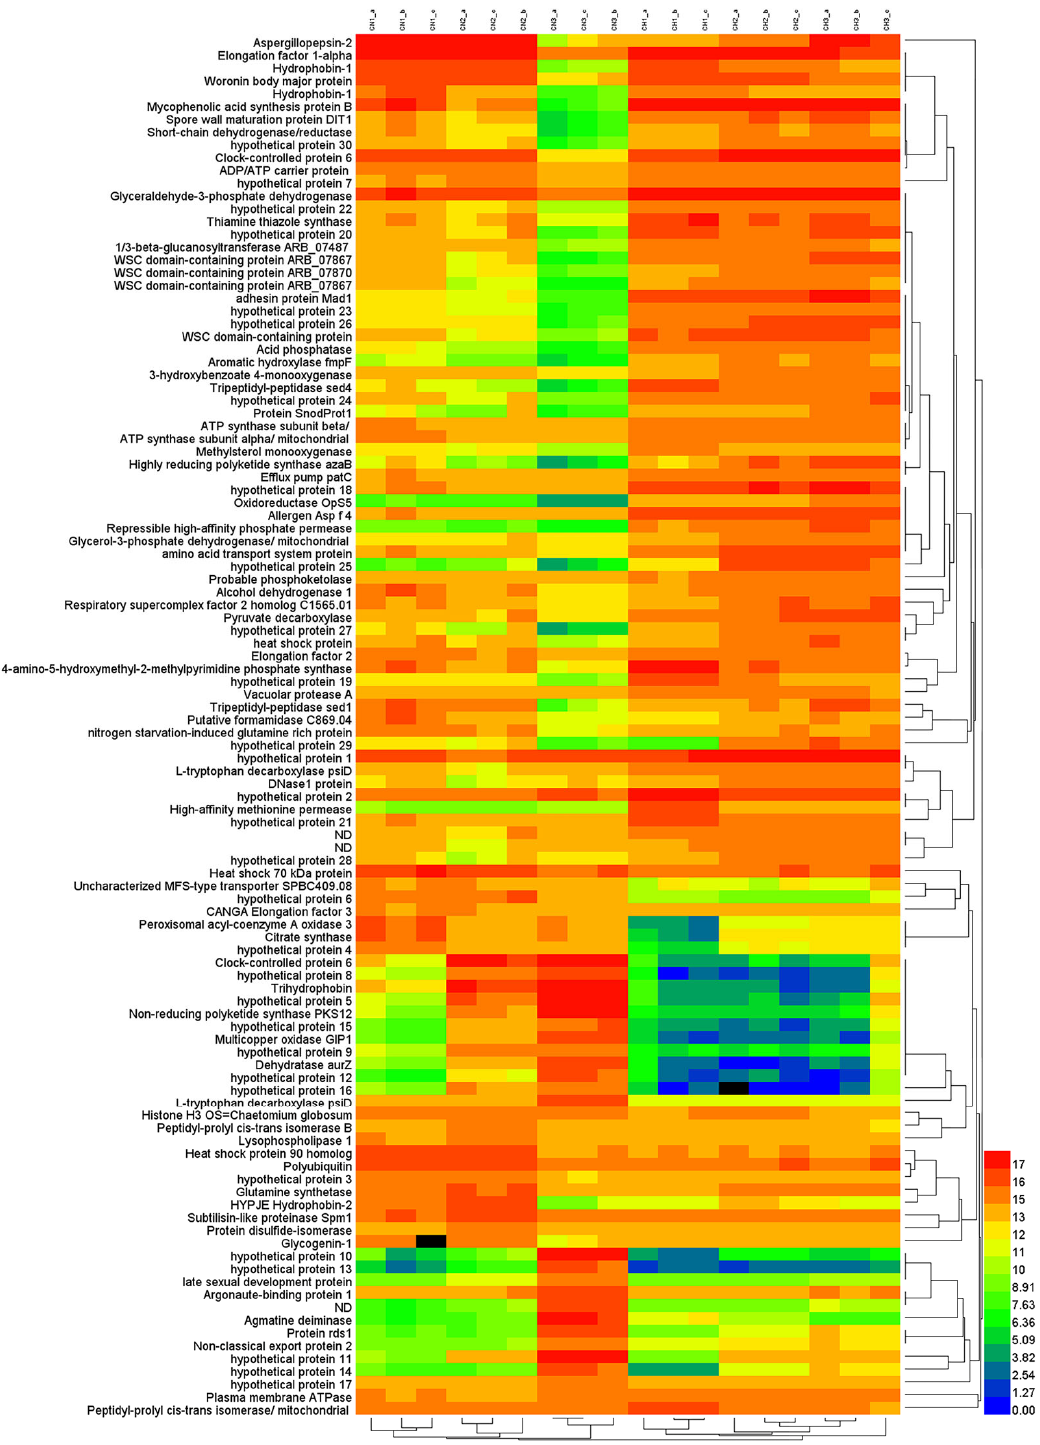
Figure 2. Heat map of the major DEGs between liquid-shaking culture and solid-surface culture. CH1/2/3 and CN1/2/3 represent liquid shaking culture and solid surface culture at 48, 72, and 96 h, respectively.